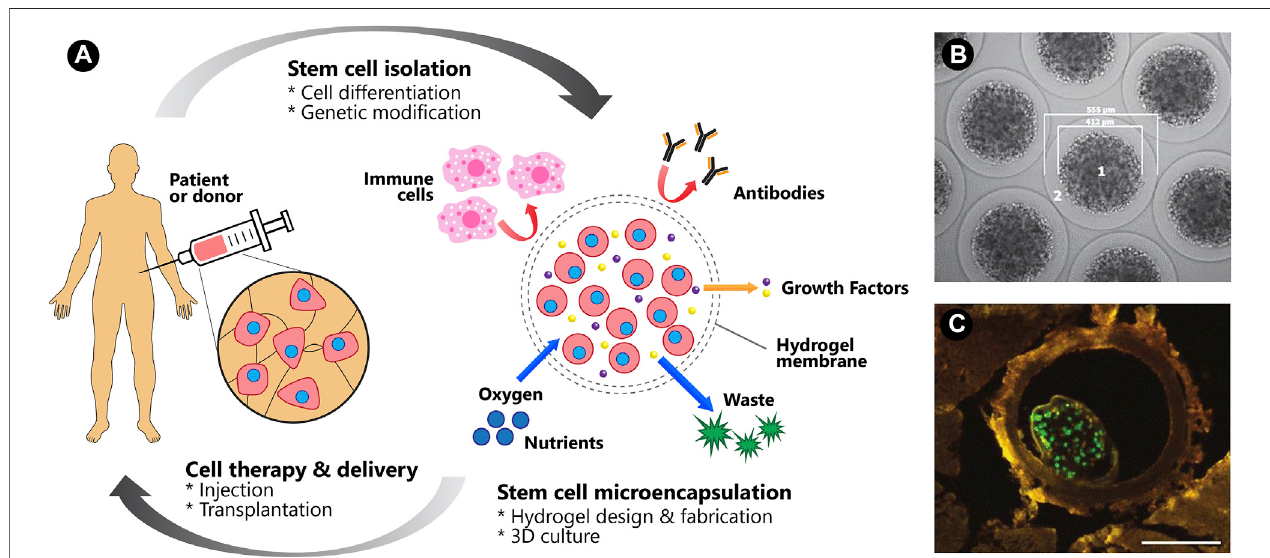
FIGURE 5 | Cell therapy and delivery. (A) A schematic of the microencapsulation of human stem cells and its bene fi ts for clinical translation. Figure adapted with permission from Figure 1 of (Choe et al., 2018). (B) GLP-1 CellBeads illustrating the central core bead containing GLP-1-secreting MSCs (1) and the surrounding alginate shell (2). (C) A green fl uorescence protein-tagged CellBead within a coronary vessel. Scale bar: 250 μ m. Figures 5B,C adapted with permission from Figures 1A,B of (Wright et al.,